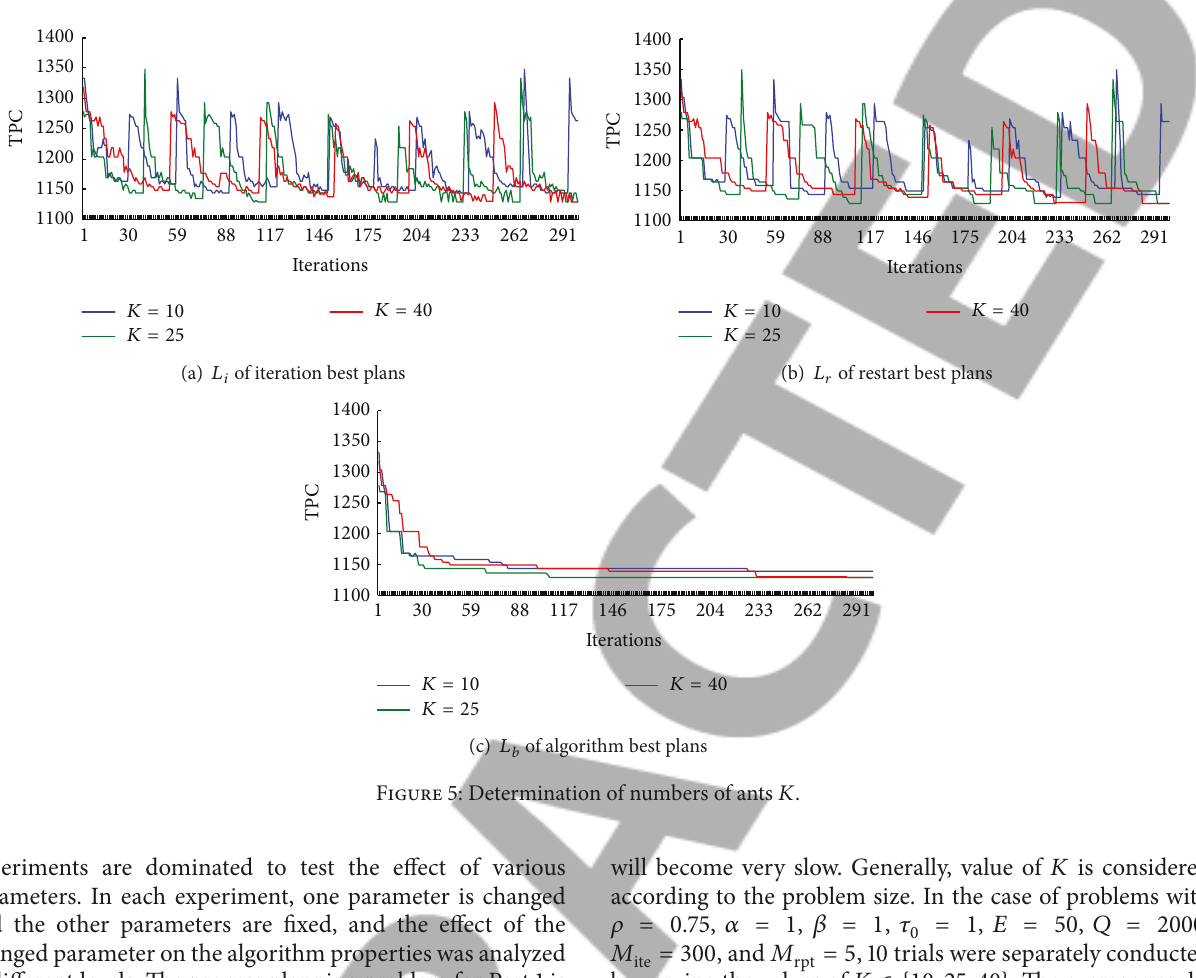
Figure 5: Determination of numbers of ants 𝐾